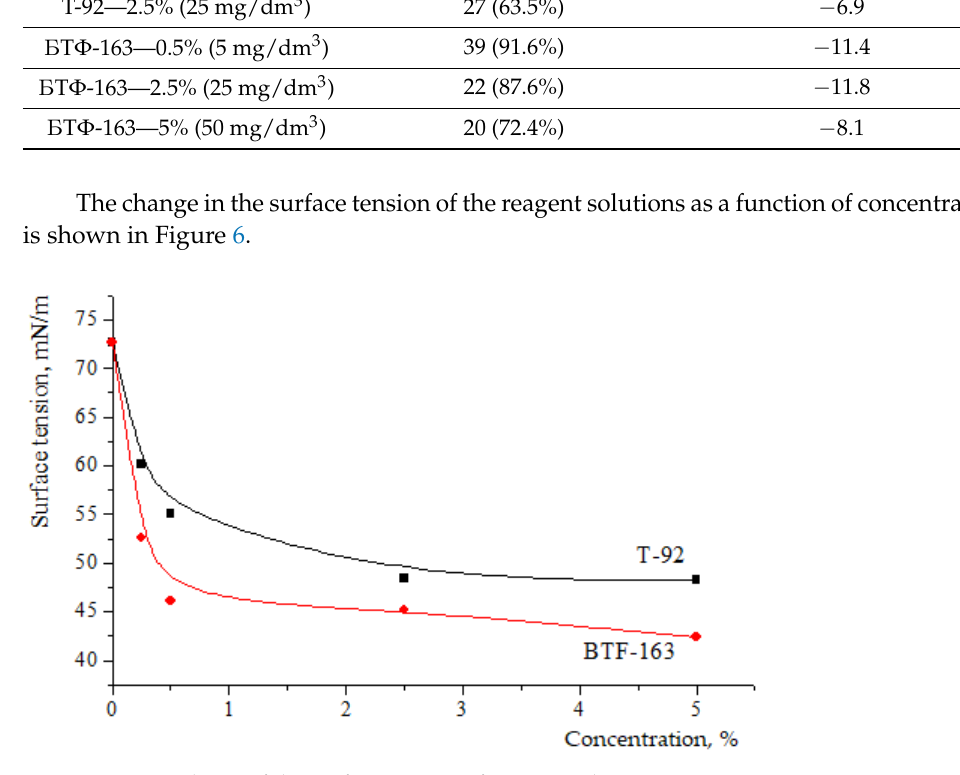
Figure 6. Dependence of the surface tension of reagent solutions on concentration. Figure 6 . Dependence of the surface tension of reagent solutions on concentration .